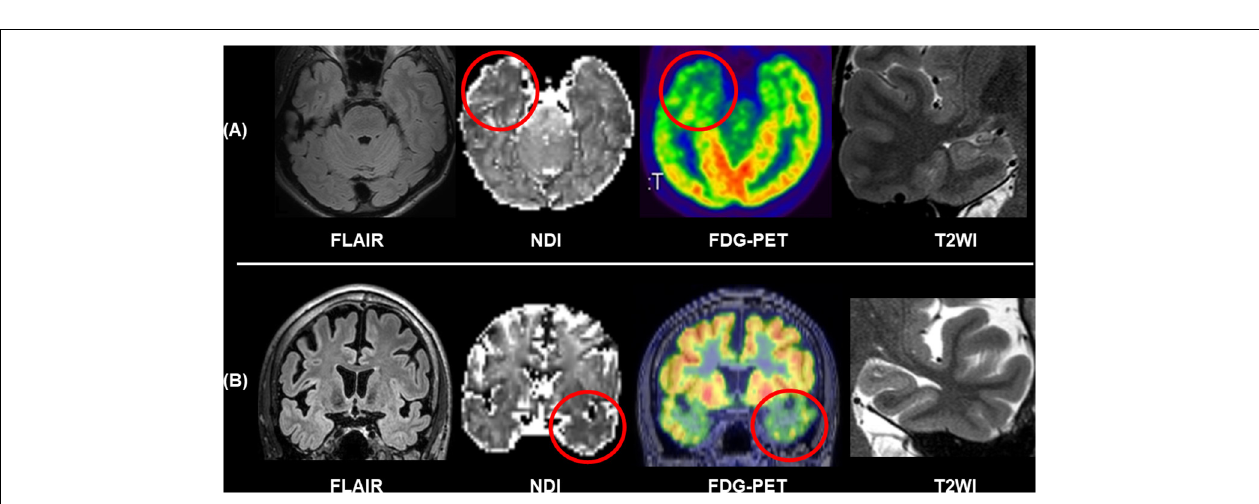
FIGURE 6 | Two cases of conventionally MRI-negative PET-positive TLE. While no abnormalities were found in FLAIR and T2WI including the hippocampus, neurite orientation dispersion and density imaging (NODDI) revealed reduced neurite density of the focus side. (A) Modified from Sone et al. (2018). (B) Modified from Sone